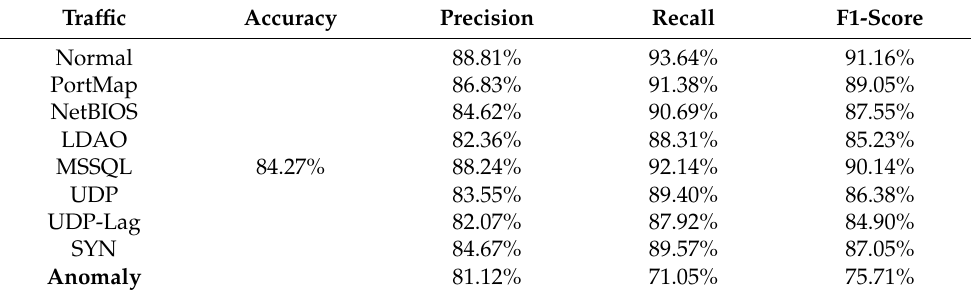
Table 13. Test results of DQN-1D-CNN with discount value γ = 0.1 and λ = 0.7. The averaged computation time for detection is 0.143 s .